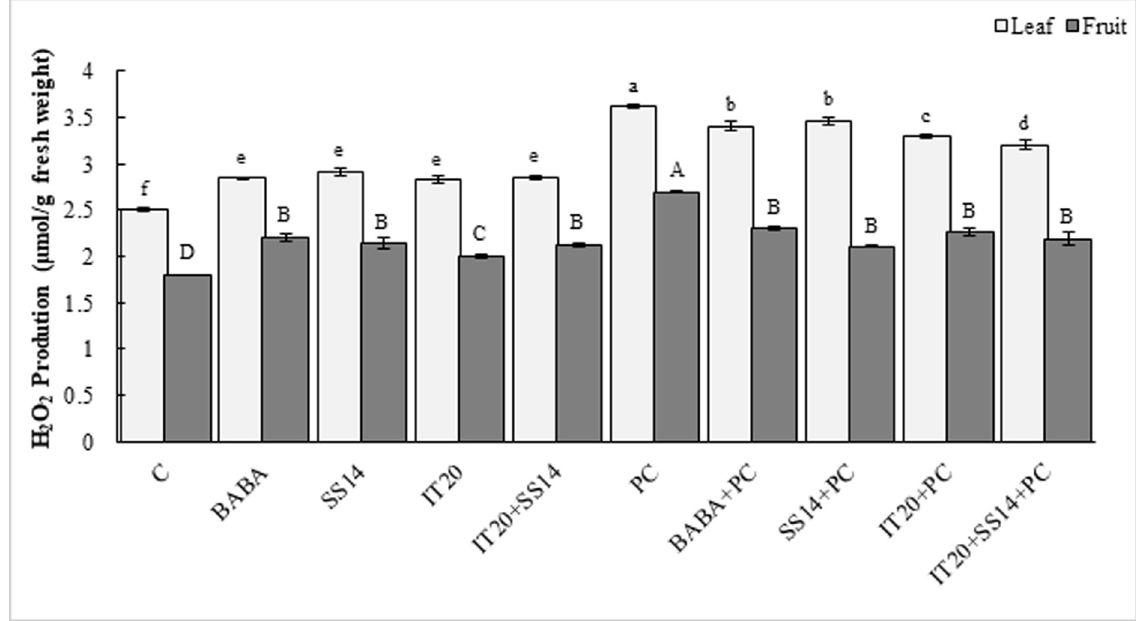
Fig 3. H 2 O 2 production in leaves and fruits of chemical (BABA), biological ( S . vinaceusdrappus SS14 or S . rochei IT20) and combination (IT20+SS14) treated plants after seven days of pathogen inoculation respectively. Same letters represent non-significant difference according to Duncan’s Multiple Range Test ( P < 0 . 05